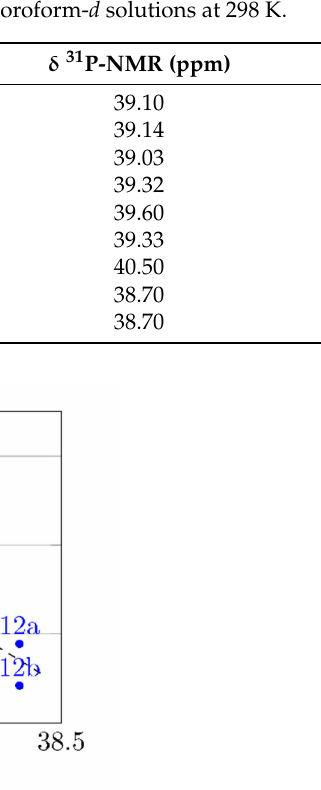
Table 4. 31 P-NMR chemical shifts of compounds 1 – 12 , in chloroform- d solutions at 298 K.